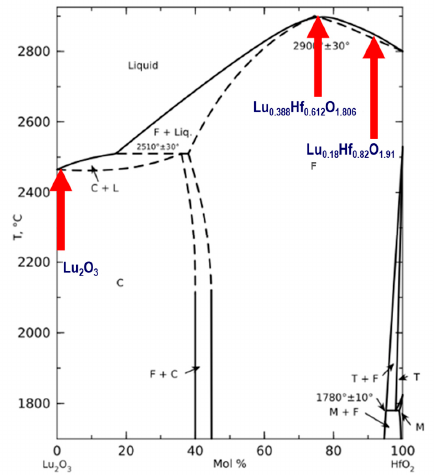
Figure 1. Phase diagram between Lu 2 O 3 and HfO 2 [1]. The chemical compositions of the crystals grown in this study are indicated by red arrows.